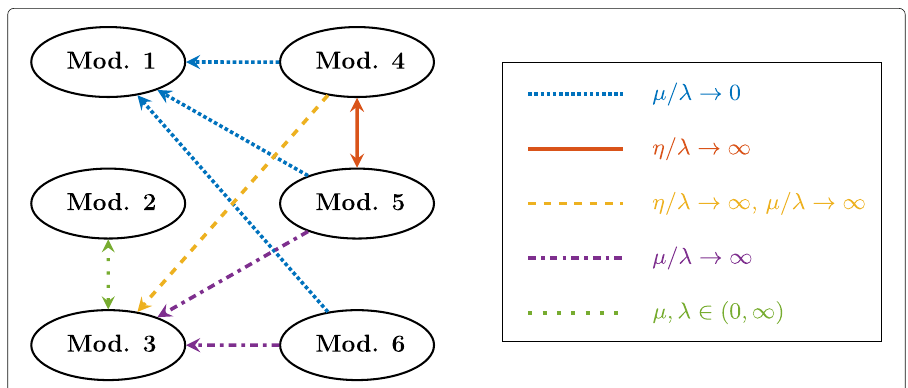
Fig. 4 Relationship between models with all-exponential distributions. The graph represents the relationships between all models when all durations are exponentially distributed. Here, μ , η and λ represent the exponential rates of the distributions, such that (cid:9) X w (cid:10) = 1 μ for the walker, (cid:9) X u (cid:10) = 1 η for the up times, and (cid:9) X (cid:10) = 1 d λ for the down times. The arrows represent pointwise convergence for all times, of the resting time PDF’s T ij ( t ) in function of the dynamical parameters. As indicated in the main text, convergence regarding model 5 was established when η = λ . Also note that (Mod. 2) and (Mod. 3) merge in the all-exponential